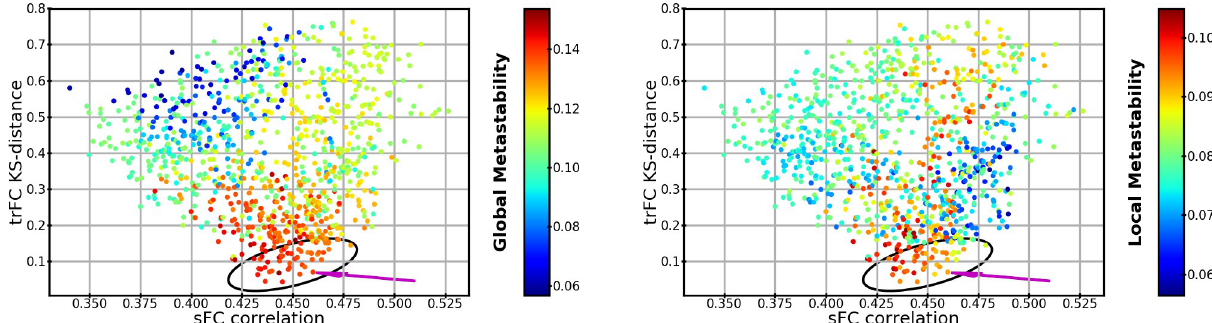
Fig 3. Global and local metastability as a function of trFC and sFC similarity between 300-second simulations with homogeneous ensembles and MEG. Each dot has the same conventions as Fig 2, but the dots are arranged by similarity to trFC (KS-distance; y-axis), and similarity to sFC (correlation; x-axis). (Left panel) Dots are colored by their global metastability. (Right panel) Dots are colored by the local metastability averaged over ensembles. The black ellipsoid marks the areas that provide a good compromise between trFC and sFC fit. Magenta arrows indicate the simulation from which we took the global parameters for the second